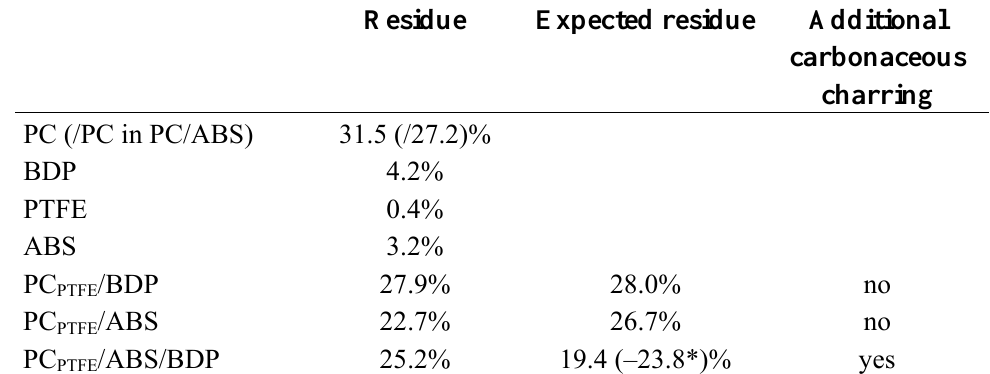
Table 2. Charring of BDP in PC determined by thermal analysis (heating rate 10 K min –1 ) under nitrogen right after